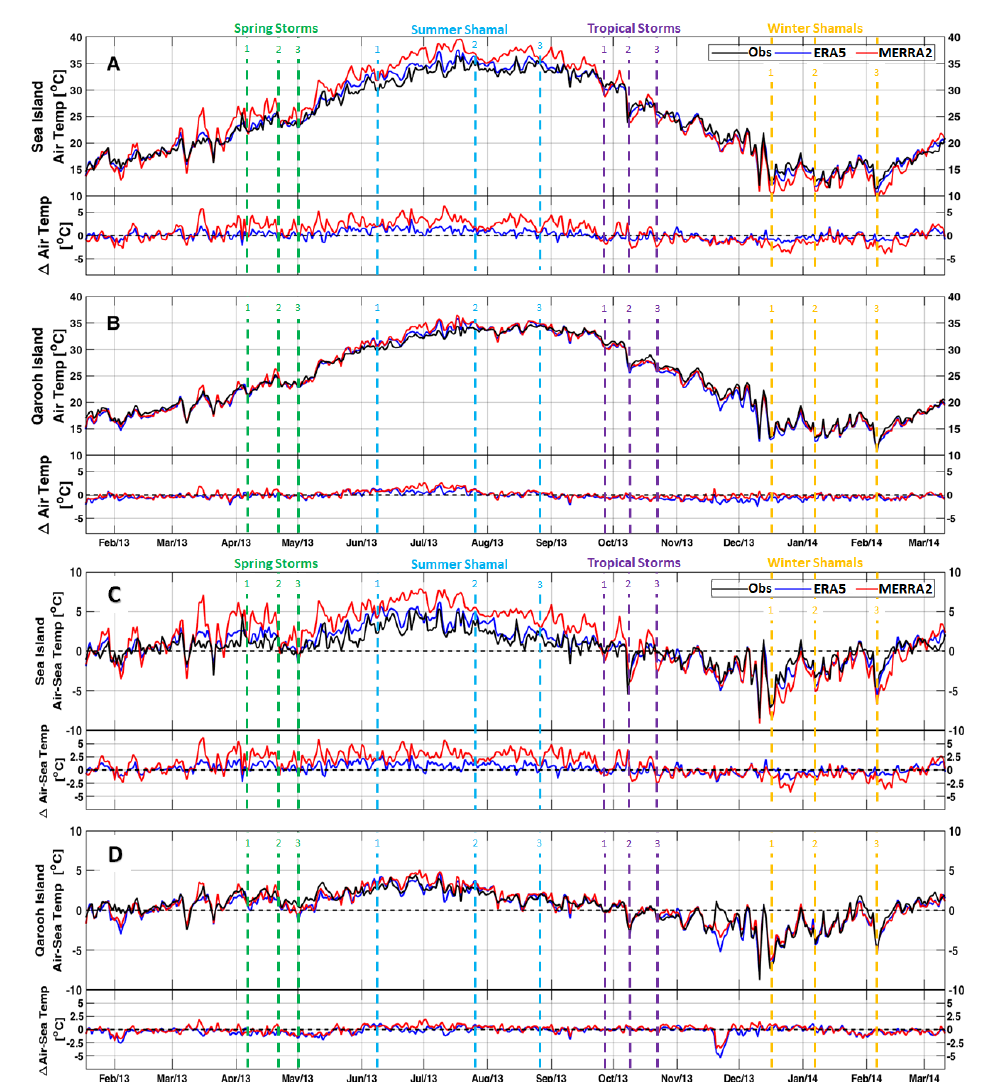
Figure 6. Daily average air temperature ( A , B ) and air–sea temperature differences ( C , D ) derived from reanalysis products (ECMWF-ERA5 blue and NASA-MERRA2 red) and observations (black). Differences can be seen at the Sea Island and Qarooh Island stations. Positive differences indicate overestimates, and vertical dashed lines indicate spring wind events (green), summer Shamals (blue), tropical storms (magenta), and winter Shamals (orange). ∆ AirTemp ( A ) and ∆ Air - SeaTemp ( B ) represent the difference between reanalysis products and